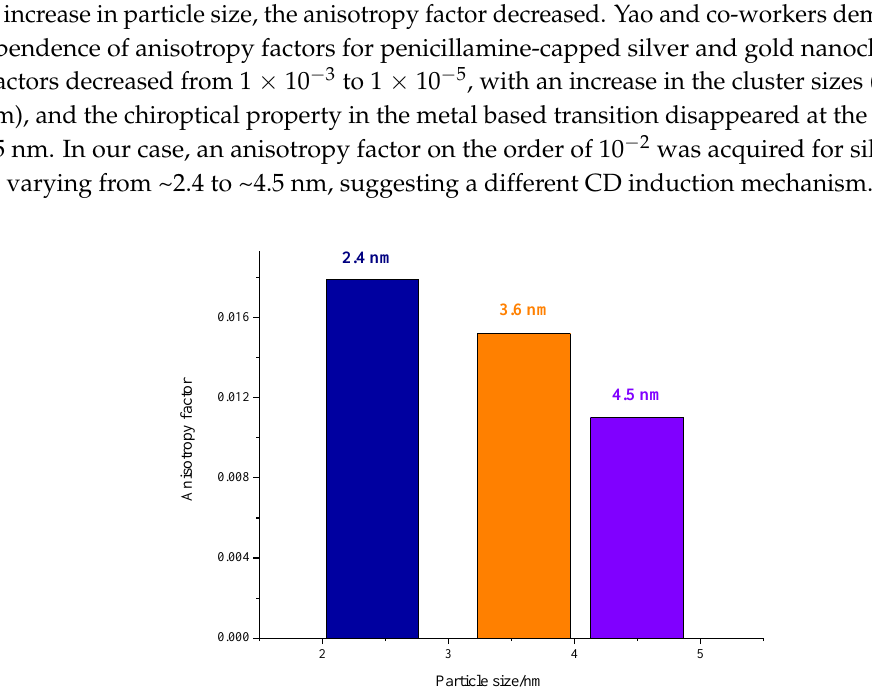
Figure 3. The relationship between the anisotropy factors and the average particle sizes of L -Cys capped Ag nanoparticles (NPs).